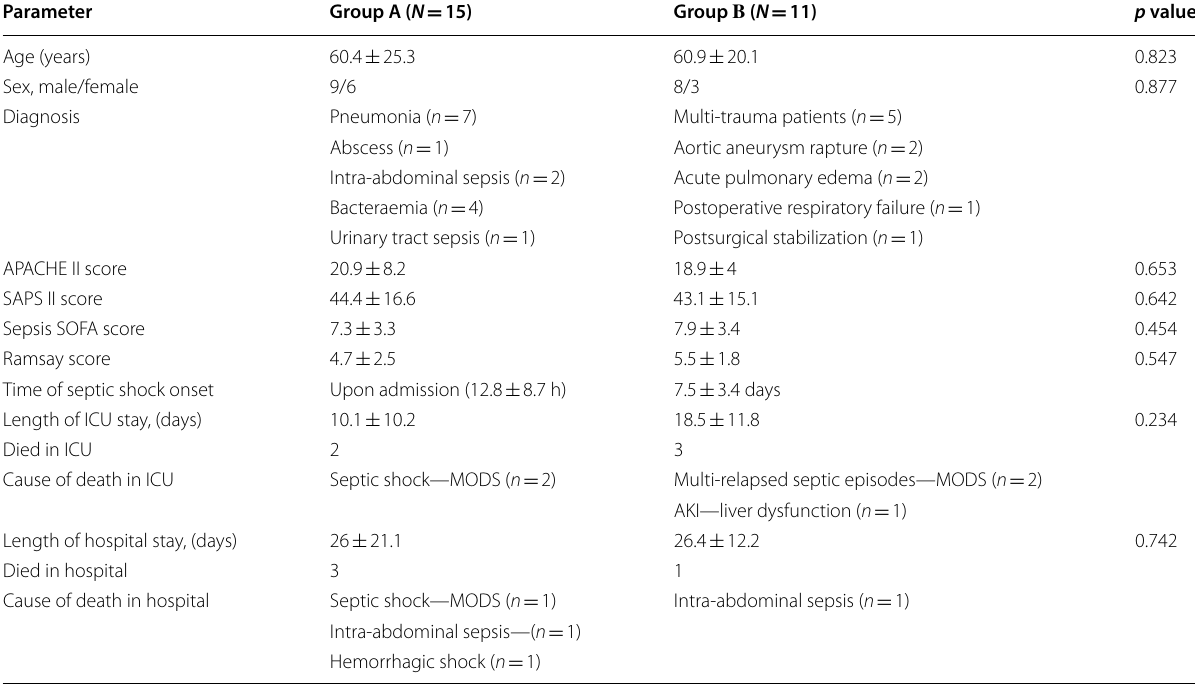
Table 1 Patients’